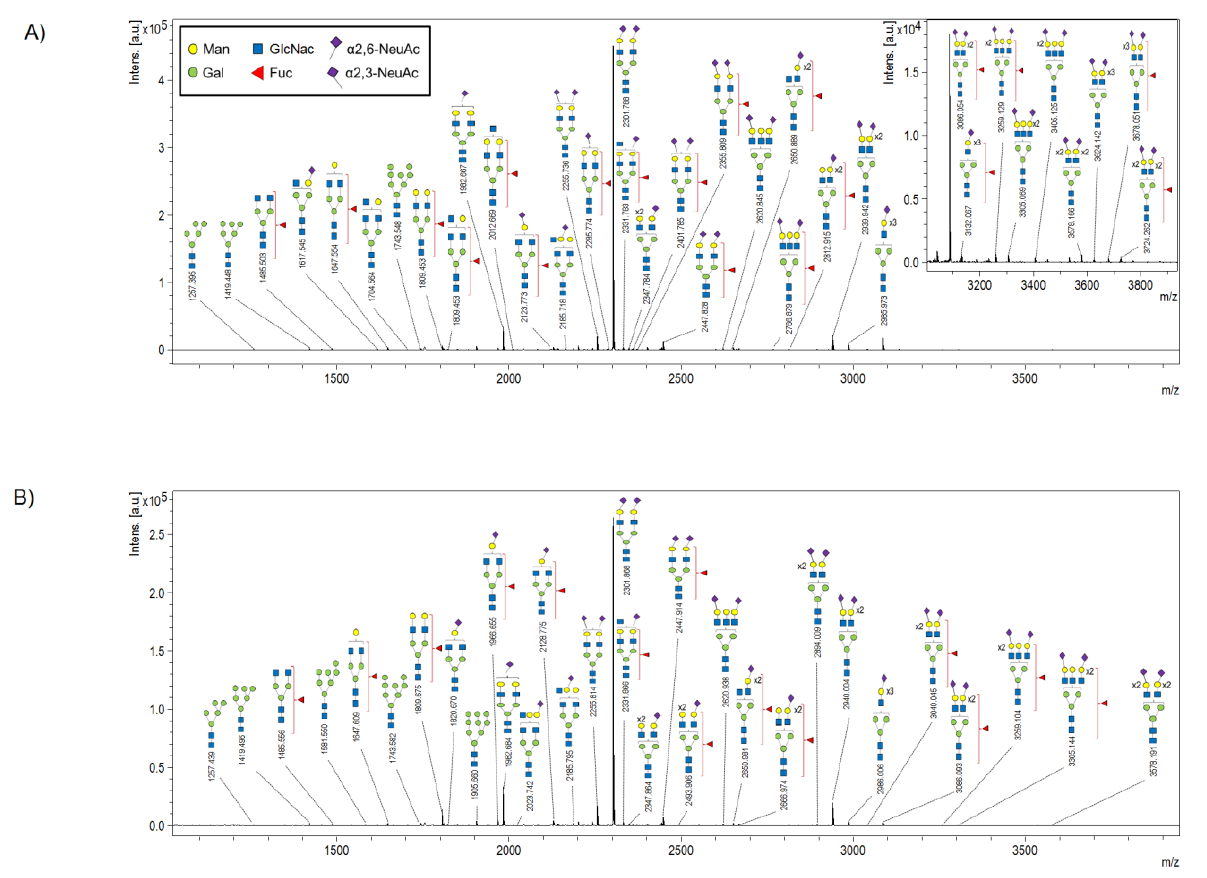
Figure 4: Representative MALDI-TOF-MS spectra of released and derivatised N-glycans (including their monoisotopic masses) obtained from FF total proteomes (FFNG) samples of (A) MNC and (B) COH groups of patients. The displayed N-glycan structures are given based on their observed masses and literature [46]. The magnified view on Figure 1A shows mass spectrum from 3000-3500 m/z region. Abbreviations: Man, mannose; Gal, galactose; Fuc, fucose; GlcNac, N-Acetylglucosamine; α 2,6- NeuAc, α 2,6 –linked sialic acid; α 2,3- NeuAc, α